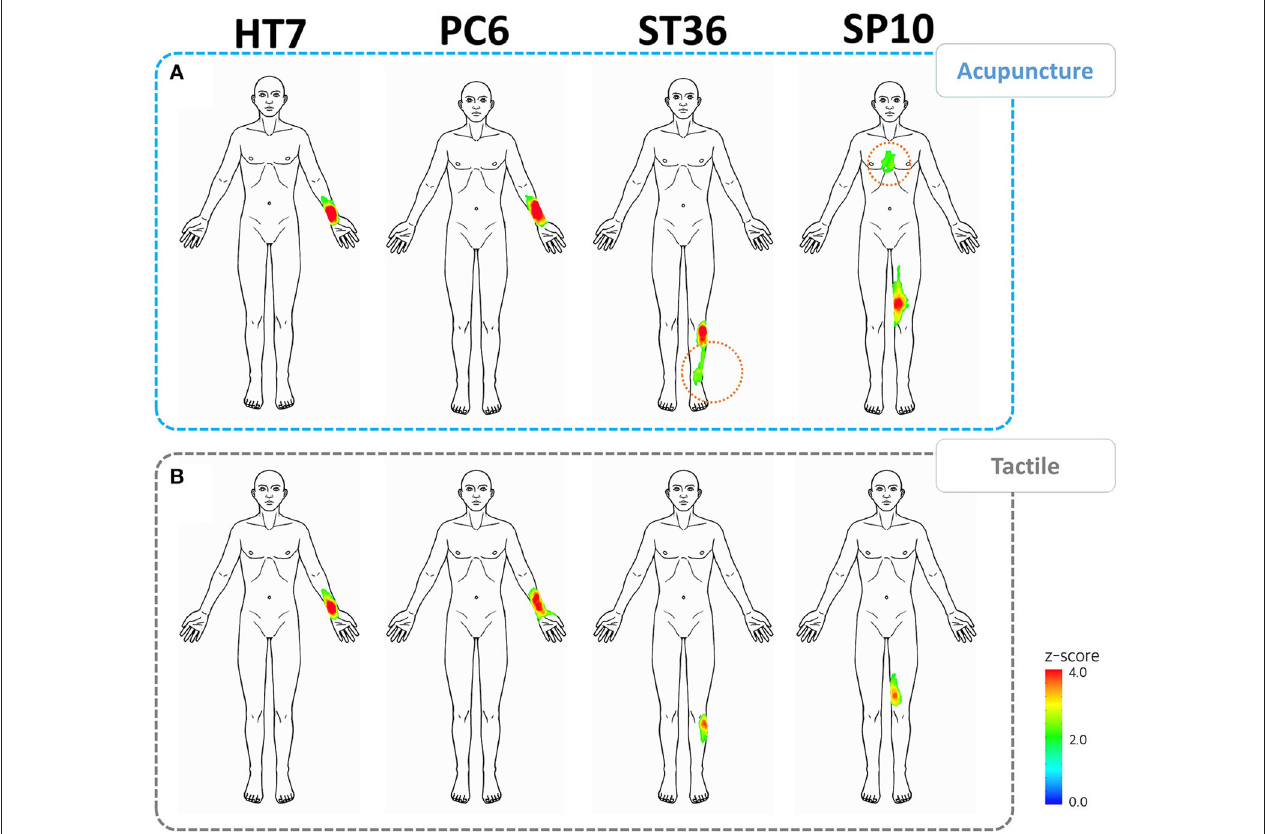
FIGURE 4 | Spatial patterns of acupuncture-induced sensations corrected for baseline bodily sensations. (A) Spatial patterns following acupuncture stimulation at the HT7, PC6, ST36, and SP10 acupoints. (B) Spatial patterns following tactile stimulation at the HT7, PC6, ST36, and SP10 acupoints. Acupuncture stimulations, especially at ST36 and SP10, were associated with larger spatial patterns, which spread farther from the stimulus sites (dotted orange